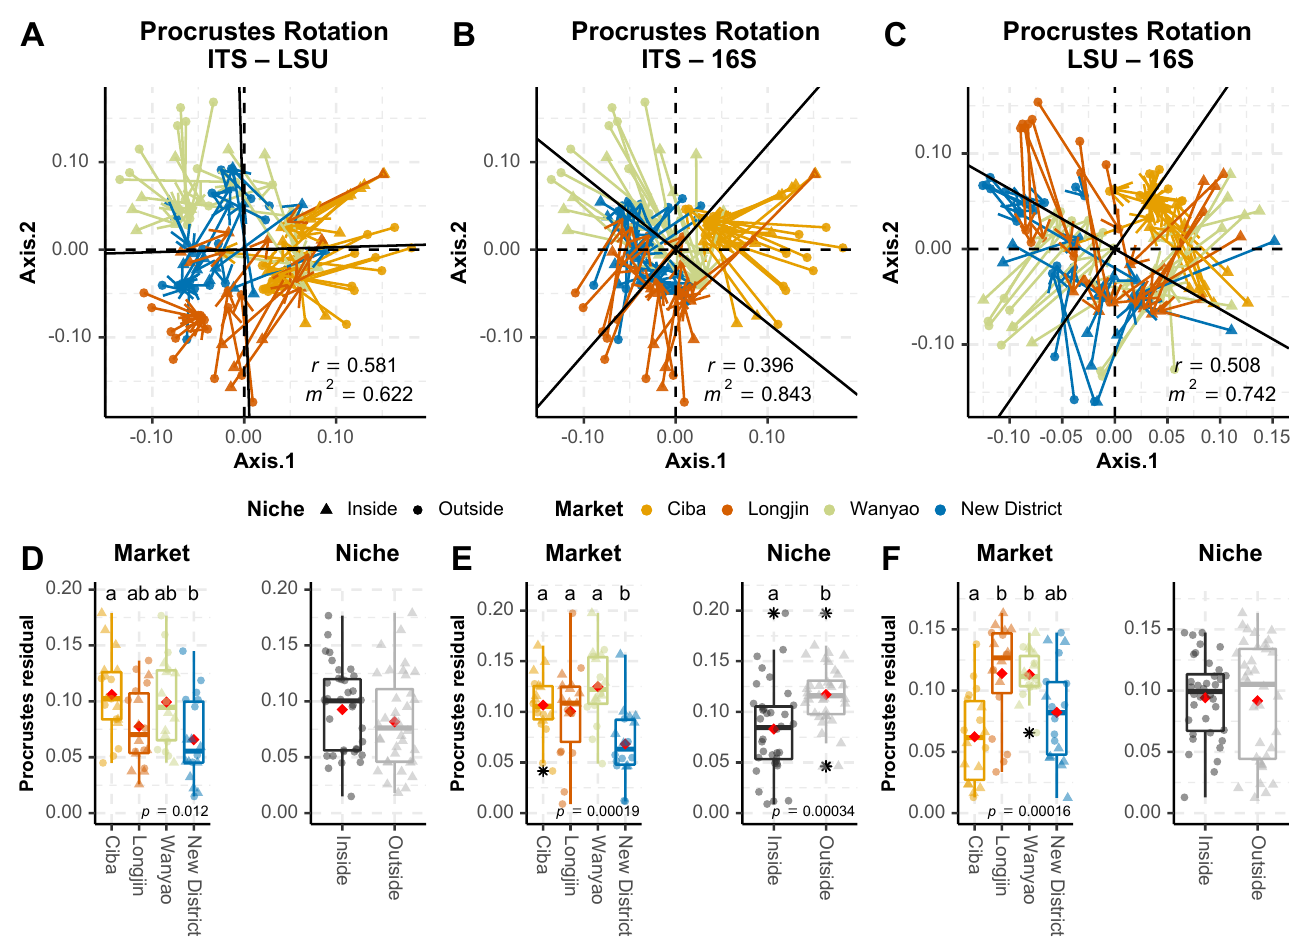
Figure 3. Procrustes plots for ( A ) ITS and LSU ordinations, ( B ) ITS and 16S ordinations, and ( C ) LSU and 16S ordinations. Each sample is represented by two points, connected by an arrow; the arrow starts at the target community and points toward the rotated community. M 2 represents the Procrustes sum of squares and r represents the correlation in a symmetric Procrustes rotation ( r = Tests were run using 9999 permutations. The distribution of Procrustes residuals for each of the comparisons and both market and niche (sample from external or internal part of tofu) is shown in ( D – F ). Letters, when present, represent pairwise Wilcoxon tests among groups after a Kruskal–Wallis test ( p ≤ 0.05 after Bonferroni adjustment). Outliers are marked with an asterisk (*). Red diamonds represent the mean of the